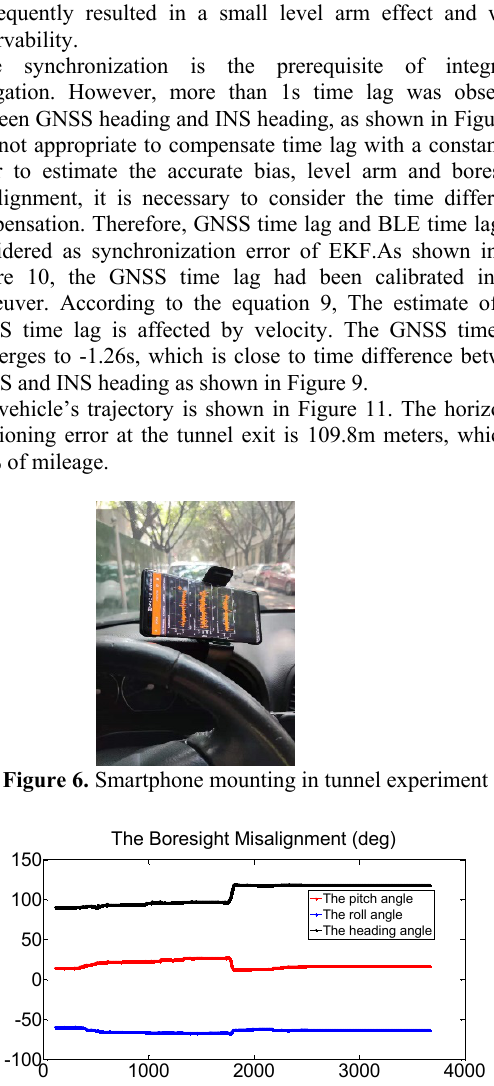
Figure 7. The boresight Misalignment in tunnel experiment.